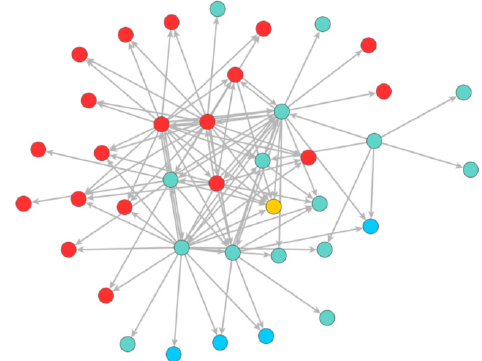
Figure 3. Power in Case 3. Legend: Having 9 interview partners and 42 actors in this network, 378 connections are possible, and 104 were observed, which results in a density of 0.26. The overall density (considering all potential relations if all the nodes had been active) is 0.060. Red = municipal/local; Turquoise = cantonal/regional; Blue = national; Orange =